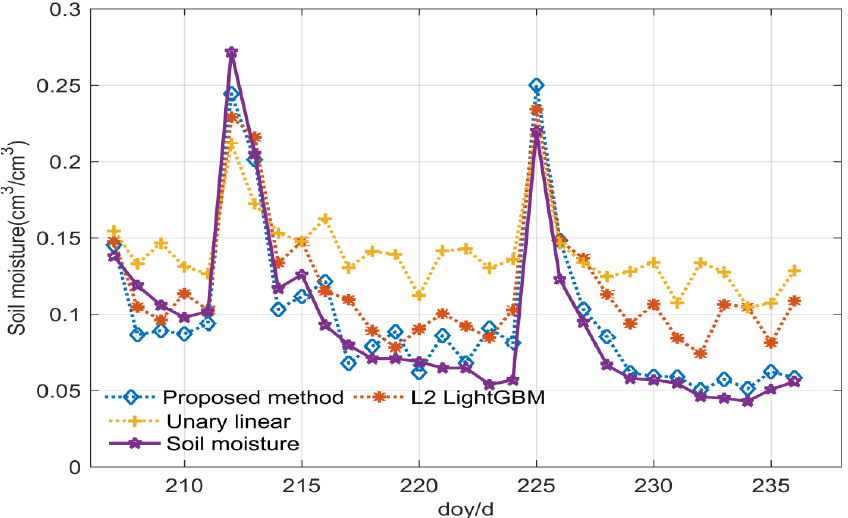
Figure 7. Retrieval results of three methods with station